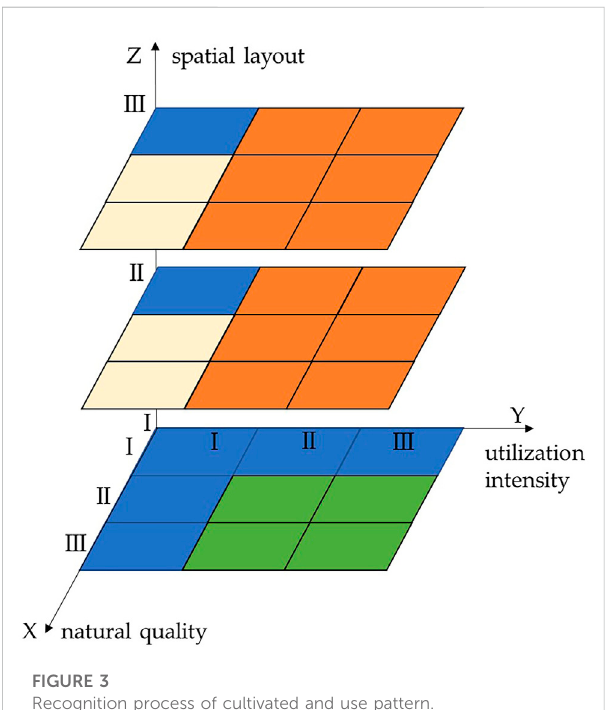
FIGURE 3 Recognition process of cultivated and use pattern.